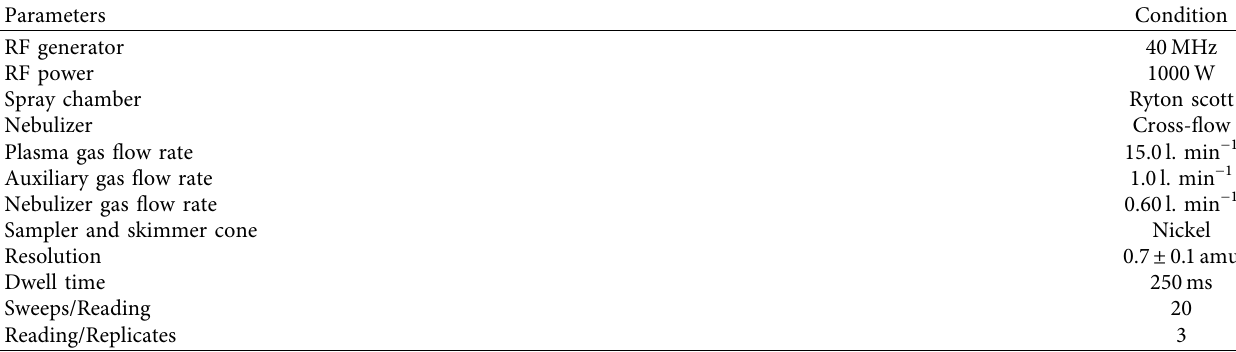
Table 1: Operating conditions for ICP-MS analysis of As, Cd, and Pb in digested samples of fingernail. Parameters